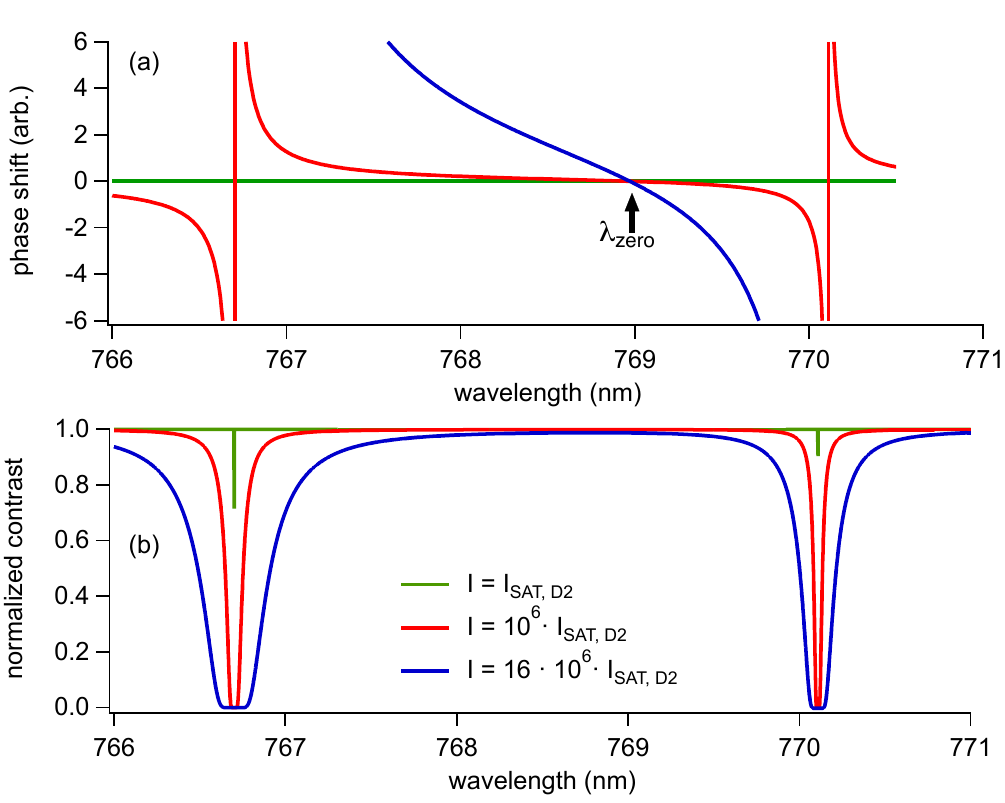
Figure 2. Phase shift and contrast loss spectra for potassium atoms, simulated for different amounts of laser power using Equations (1), (2) and (11). λ zero is the root in the phase shift spectrum in between two resonances. Contrast loss due to photon scattering occurs near the D1 and D2 resonances. We use the sharpest features of ( b ) to calibrate λ zero measurements modeled in ( a